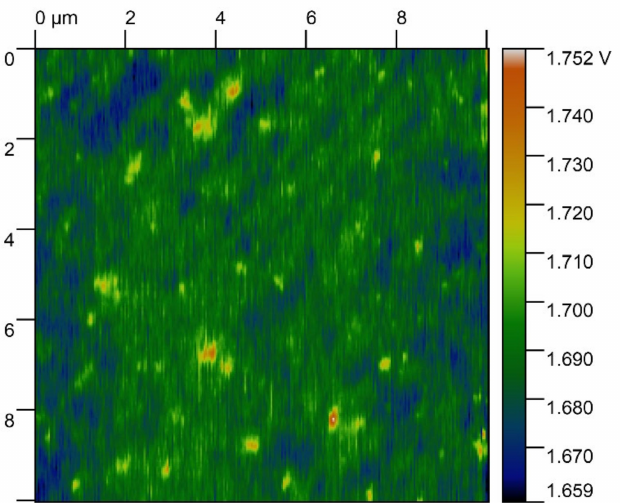
Figure 3. Representative image of surface electrical potential for sod-lime glass samples after irradia- tion at a 60-degree